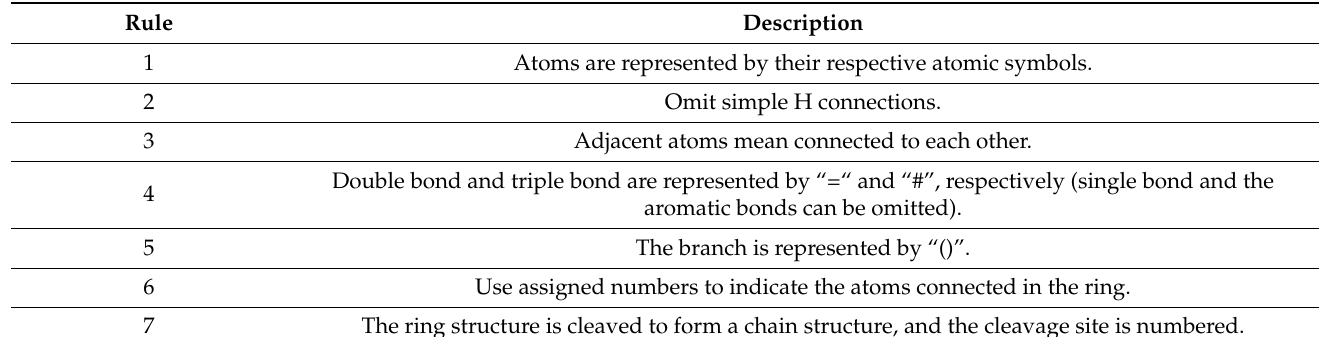
Table 1. Some conversion rules of SMILE. Rule